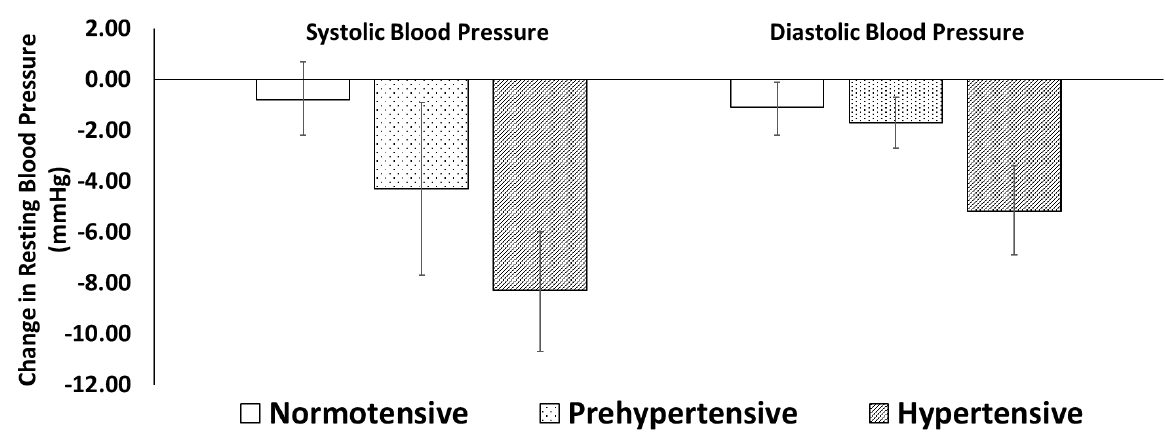
Figure F5-4. Blood Pressure Response to 16 Weeks of Aerobic Exercise